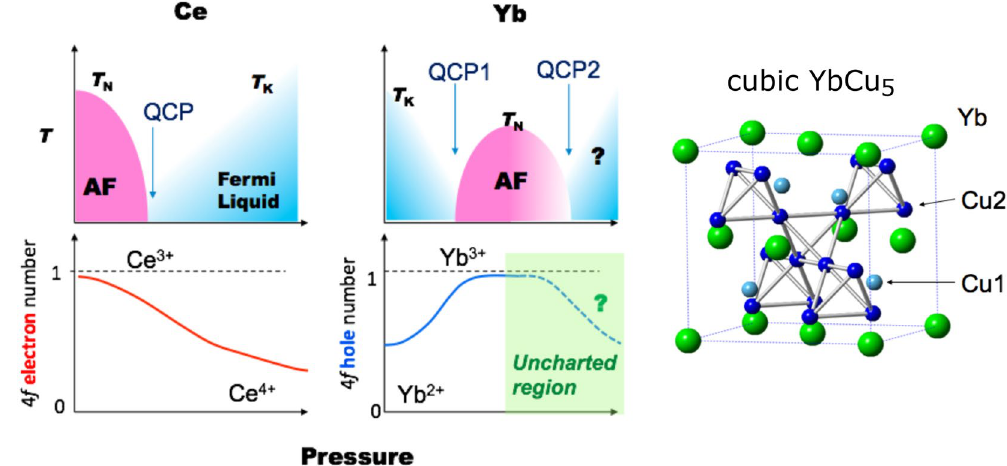
Figure 1. Schematic of the pressure-temperature phase diagrams and pressure dependence of 4 f electron numbers for Yb and Ce systems, where T N , T K , and AF are Néel temperature, Kondo temperature, and antiferromagnetic ordered sate, respectively 3, 5 . In the Yb system, two quantum critical points (QCPs) are possibly observed. An image of the crystal structure of cubic YbCu 5 is also